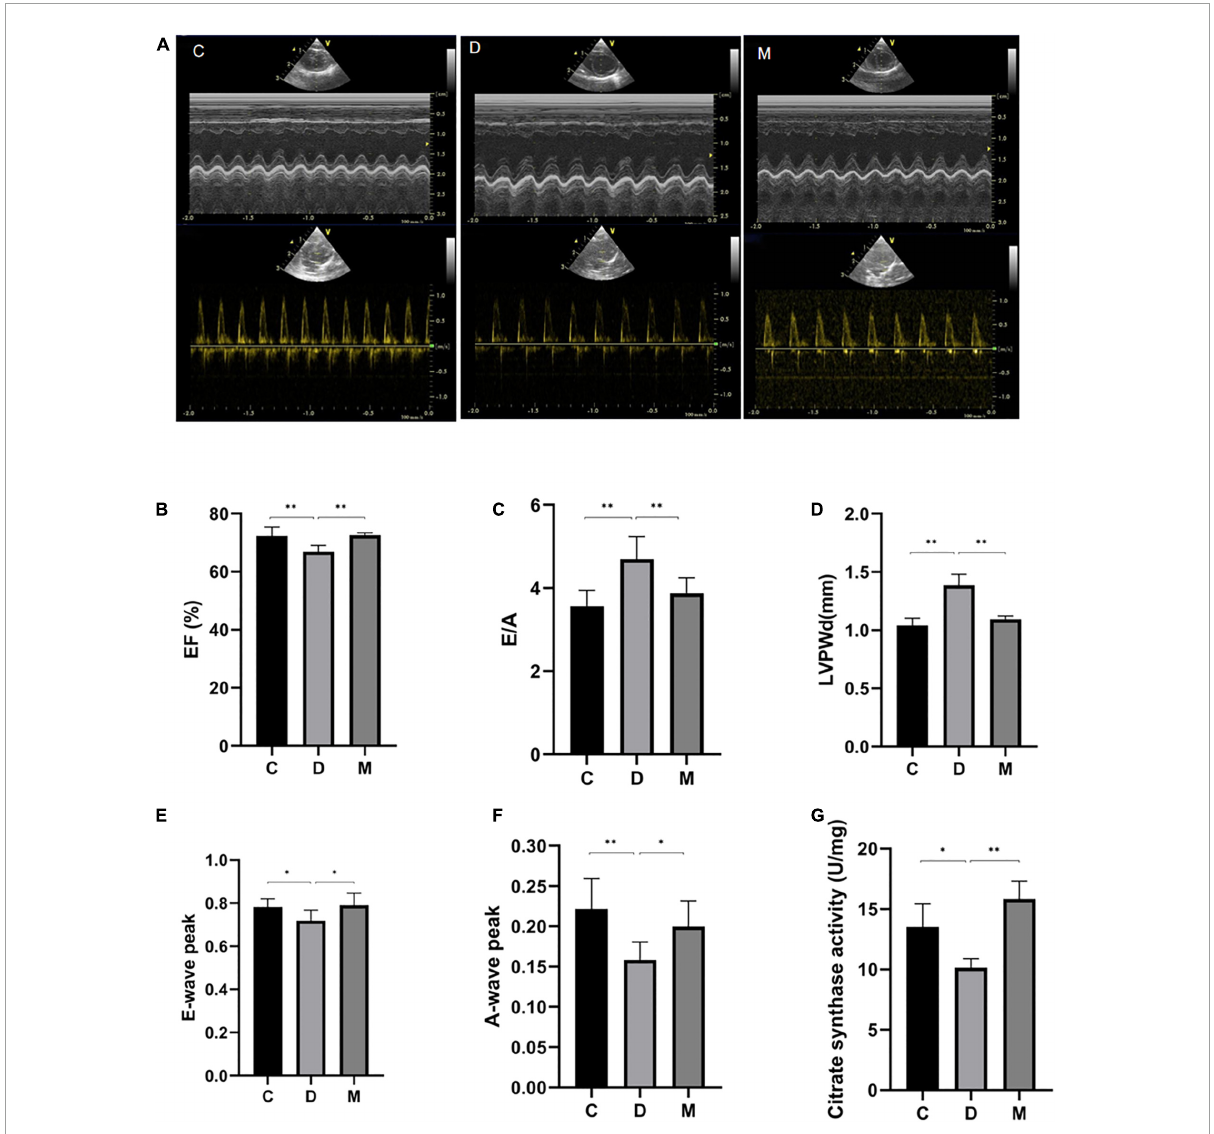
FIGURE3 Cardiac function after 8 weeks of treatment with MOTS-c. (A) M-mode echocardiographic images and echocardiographic doppler color flow images from rats in groups C, D and M. (B) Rats from groups C and M had greater EF values compared with rats from groups D ( p < 0.01), with no significant differences in EF between rats from groups M and C ( p > 0.05). (C,D) The E/A ratio and LVPWd were increased in rats from group D compared with rats from group C ( p < 0.01). While the E/A ratios and LVPWd in rats from group M were decreased compared with rats from group D ( p < 0.05), there were no differences from rats in group C ( p > 0.05). (E) The E-wave peak was decreased in rats in group D compared with the C group ( p < 0.05). Rats from group M had higher E-wave peak values compared with rats from group D ( p < 0.05), with no significant differences between rats from groups M and C ( p > 0.05). (F) The A-wave peak in rats from group D was decreased compared with rats from groups C and M ( p < 0.01, p < 0.05). (G) Citrate synthase activity in left ventricle from rats in groups C, D, and M. Data are expressed as mean ± SD; n = 10 rats in each group; ∗ p < 0.05, ∗∗ p < 0.01; C, non-diabetic control group; D, diabetic control group; M, diabetic MOTS-c injection group.